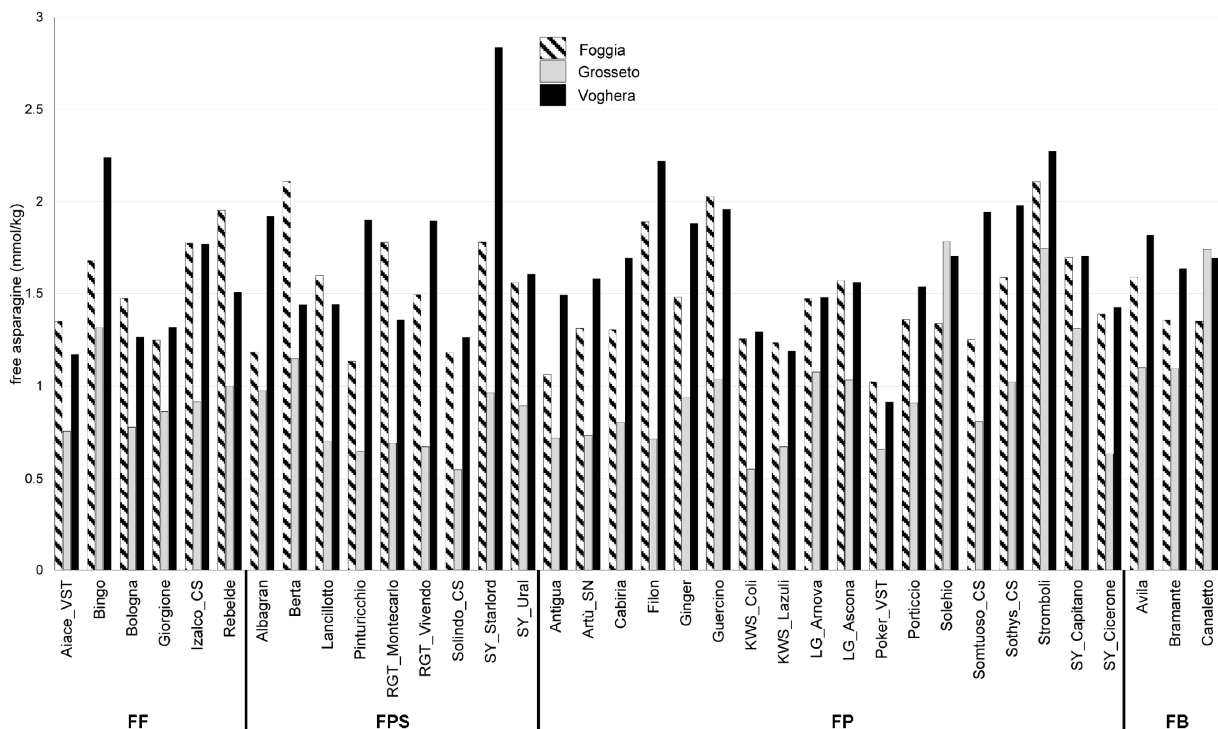
Figure 2. Concentration of fAsn in the grain of 36 bread wheat varieties grown in 2019–2020 in the three locations Foggia, Grosseto, and Voghera. FF: improver wheat; FPS: superior bread making wheat; FP: ordinary bread making wheat; FB: wheat for biscuits.